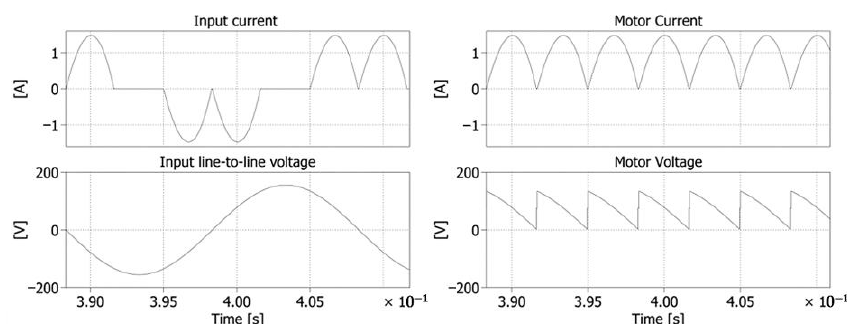
Figure 5. Main circuit structure.